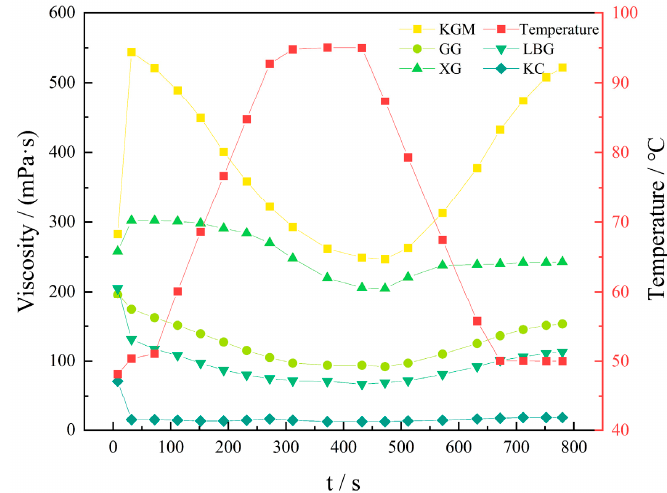
6 of 20 with the increase in temperature and vice versa. The viscosity of the KGM solution signif- icantly changed with temperature due to the large pseudoplasticity. Similarly, the viscos- ity decreased by 278 mPa·s with high temperatures. Therefore, it was inferred that the viscosity could return to the initial level under decreased temperature, and LBG and KC solution have less effect on temperature change due to the lower viscosity.